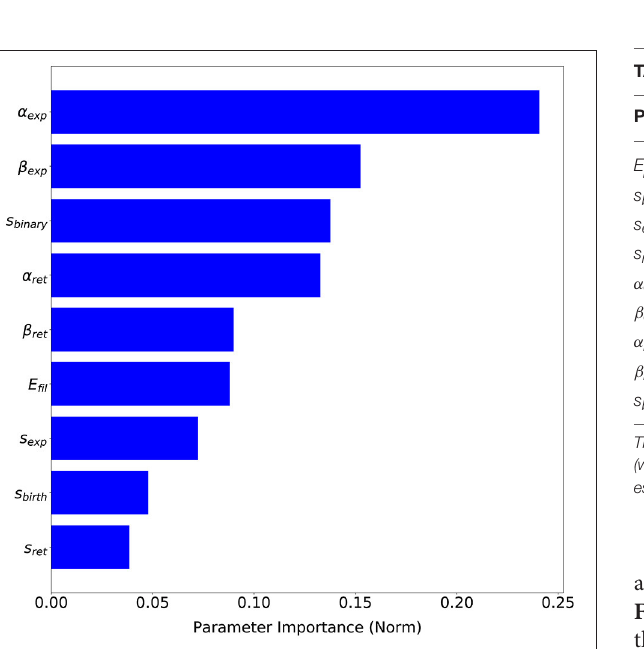
FIGURE 9 | Parameters sensitivity based on SigOpt analysis of each parameter importance on the proposed evaluation metrics.